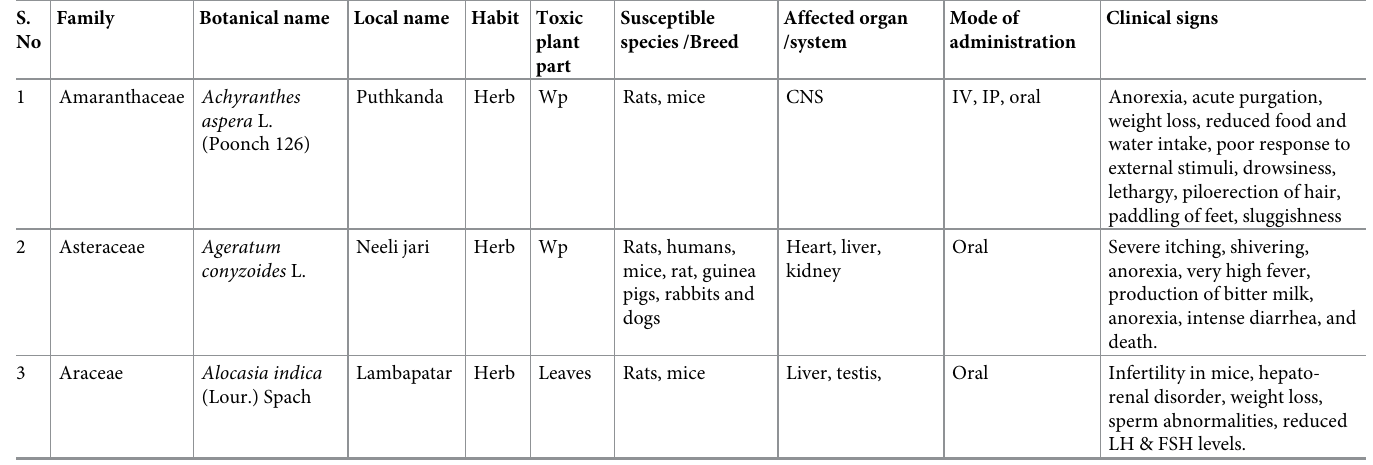
Table 2. List of poisonous plants with their botanical names, toxic plant parts, route of administration and signs. S. Family Botanical name Local name Habit Toxic No